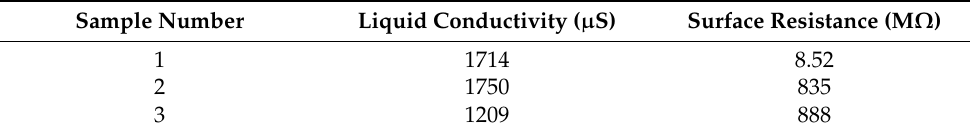
Table 10. The results of the surface conductivity and resistance